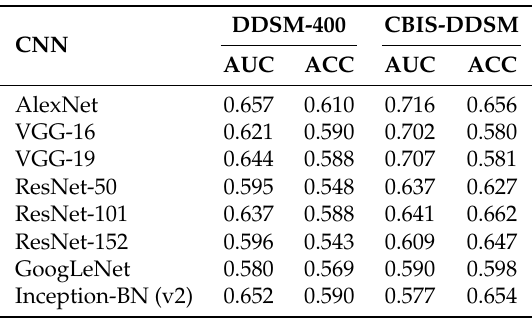
Table 2. Performance of deep neural networks using the from-scratch training scenario.